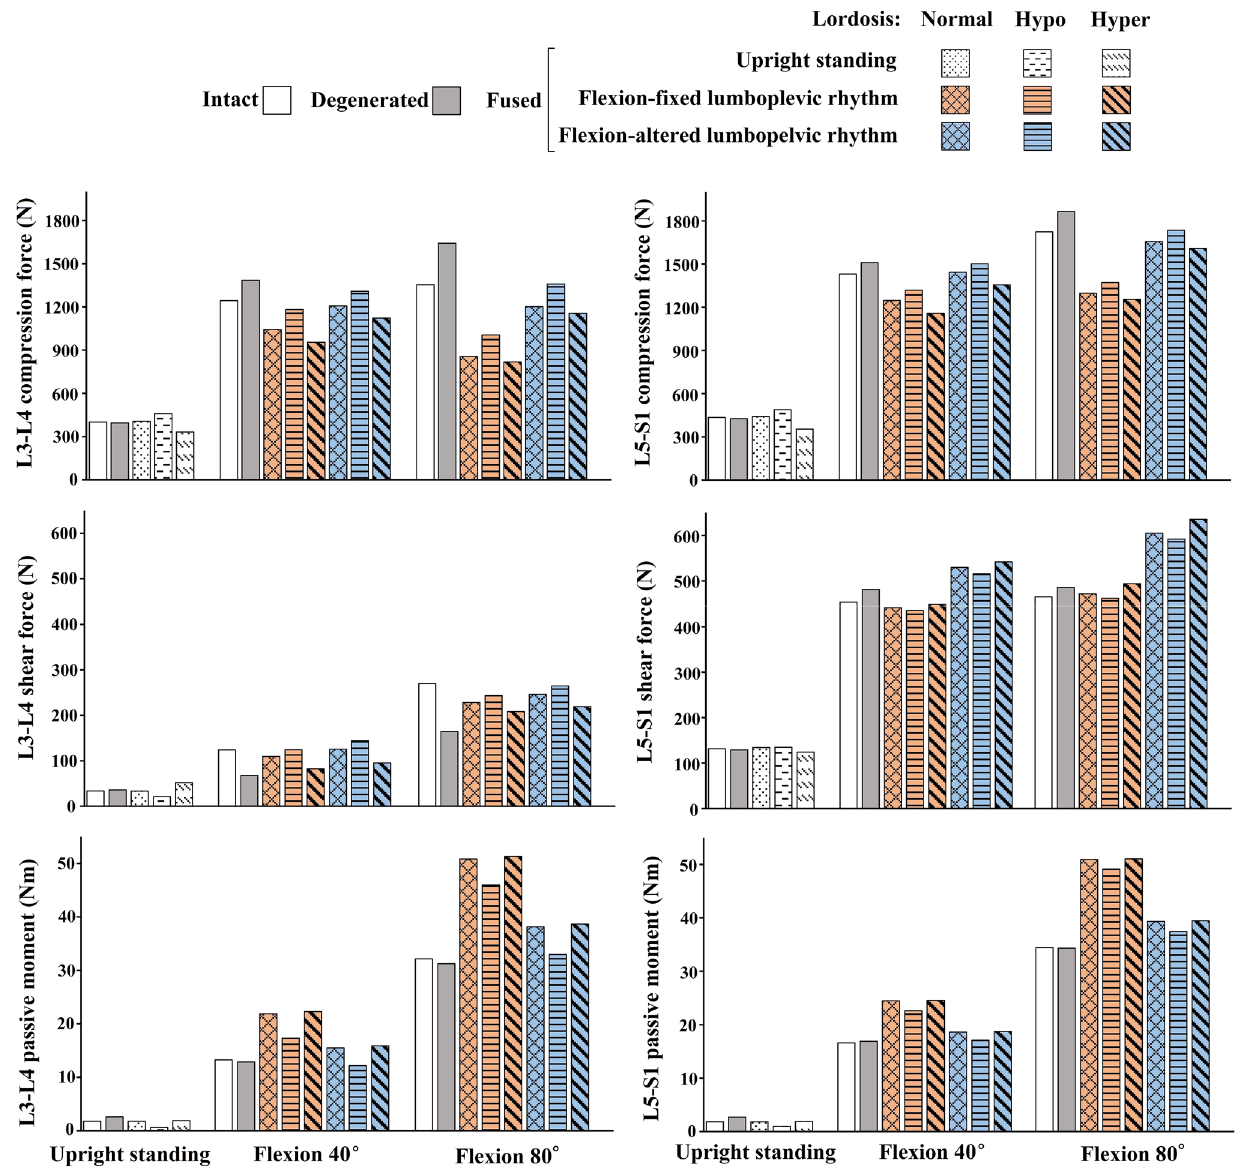
Figure 5. Compression force (N) (top), shear force (N) (middle) and passive moment (Nm) (bottom) at the upper (L3-L4) (left) and lower (L5-S1) (right) adjacent disc mid-planes for the preoperative intact and degenerated as well as postoperative fused states in the upright and two flexed postures (40 and 80°). Results for all simulated flexion tasks are given in Supplementary Table